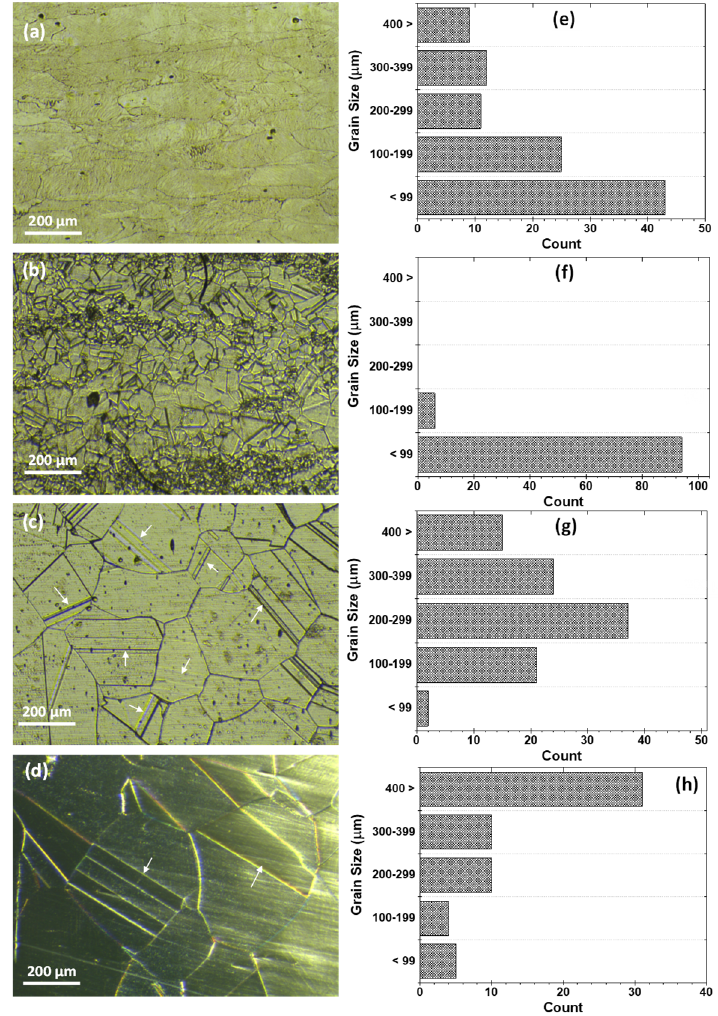
Figure 5. ( a – d ) Optical micrographs and ( e – h ) grain size distribution for heat-treated samples ( a , e ) AT10, ( b , f ) AT11, ( c , g ) AT12, and ( d , h ) AT13 .